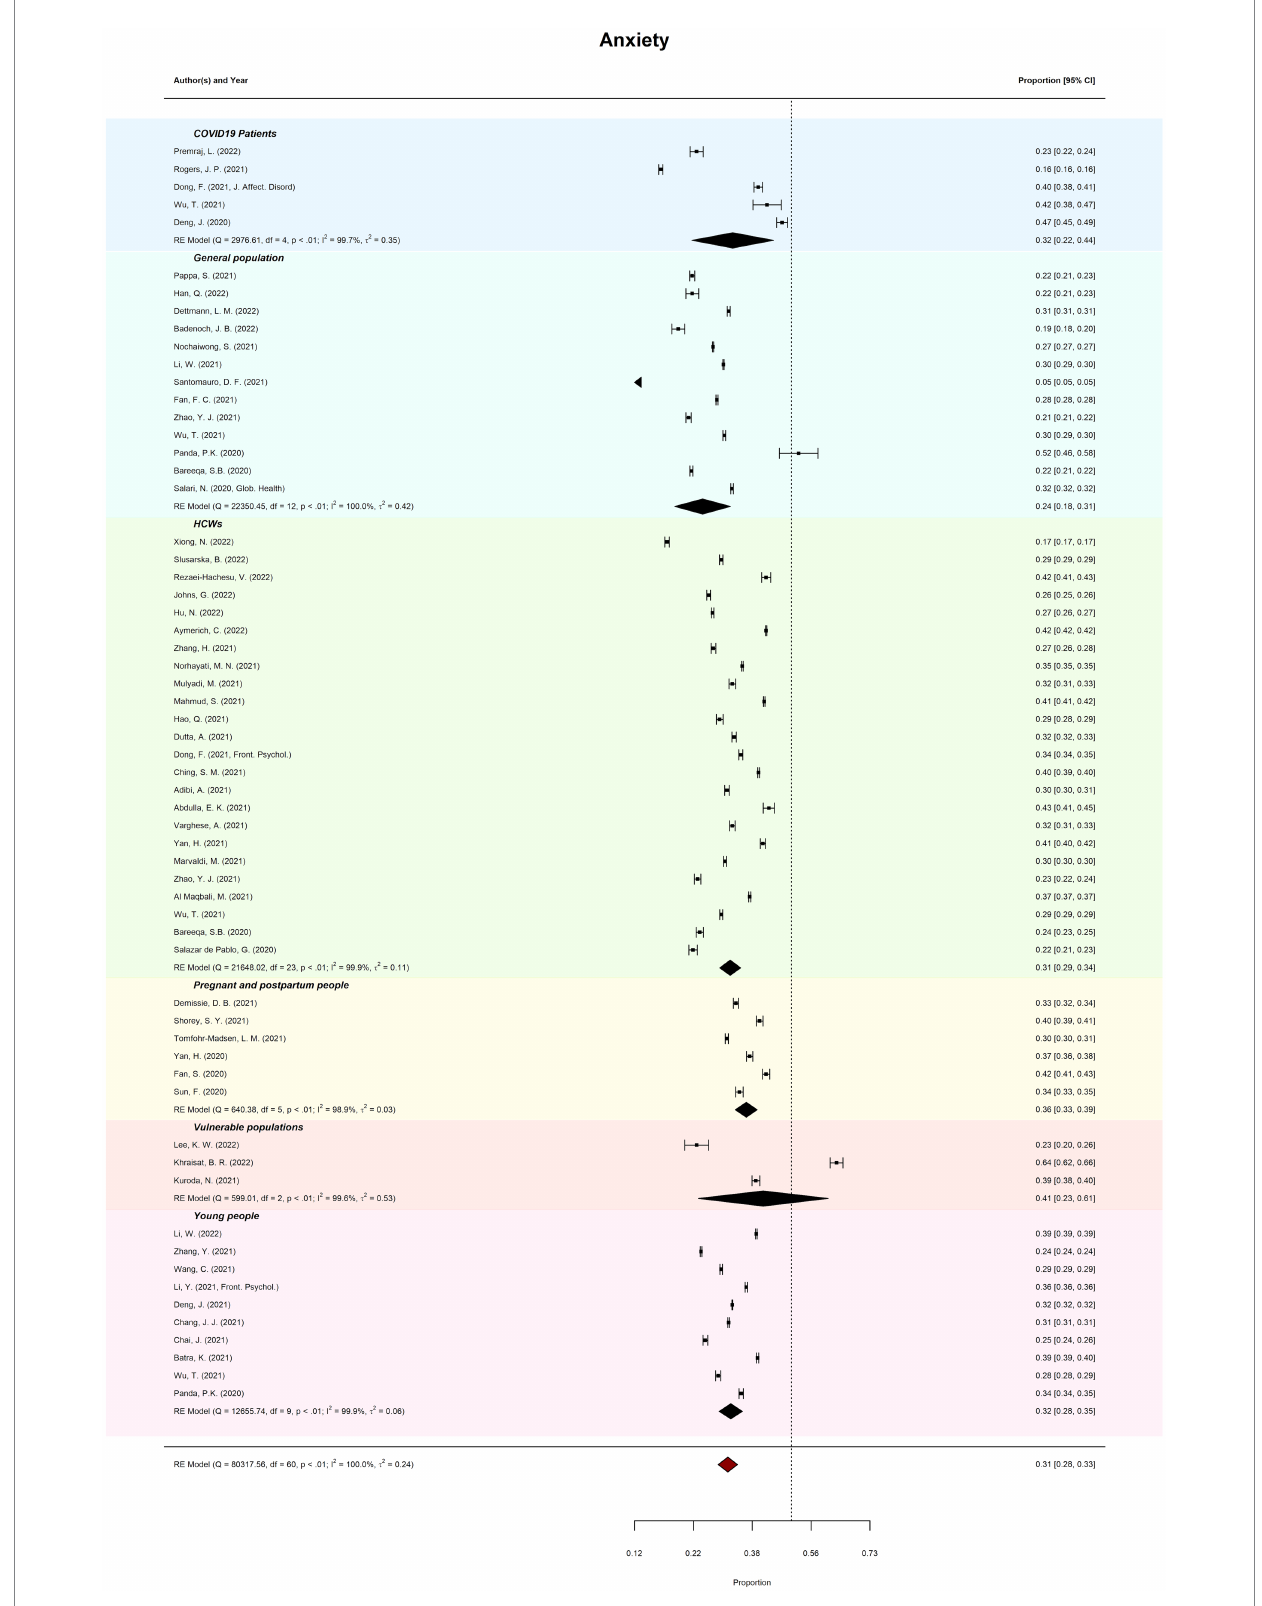
FIGURE 3 Meta-review of pooled prevalence of anxiety. The forest plots of probable anxiety prevalence (with 95% CIs) across all